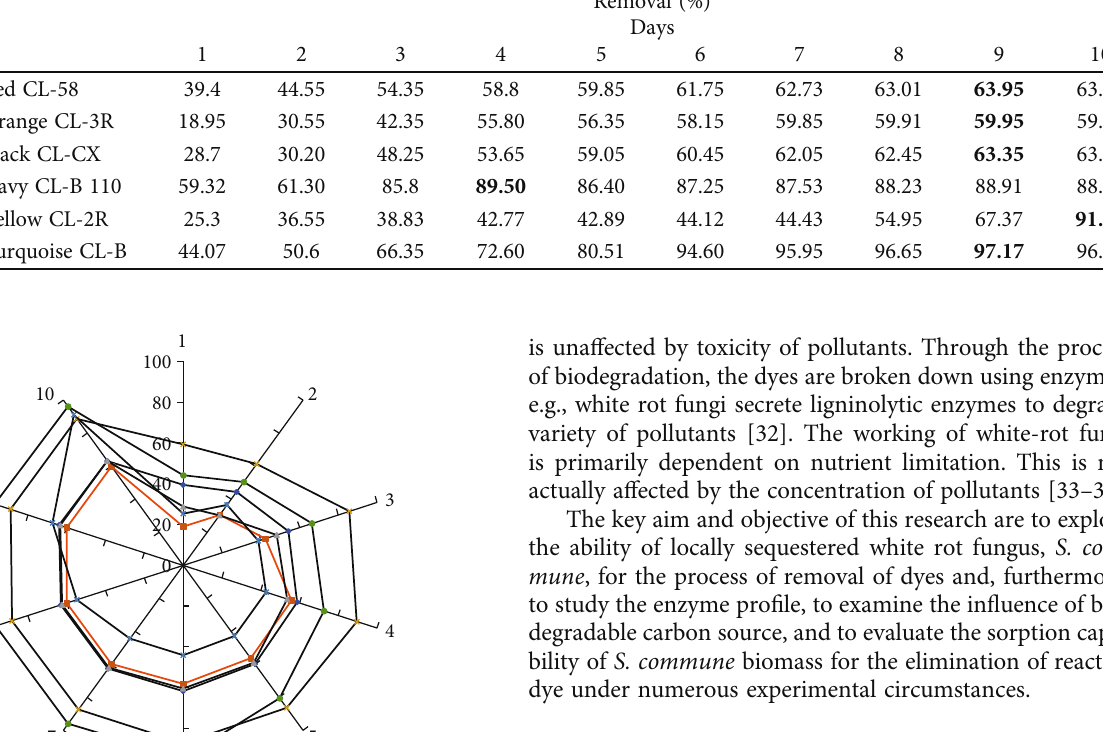
Table 1: Time course study for the removal of reactive dyes using S. commune . Dyes